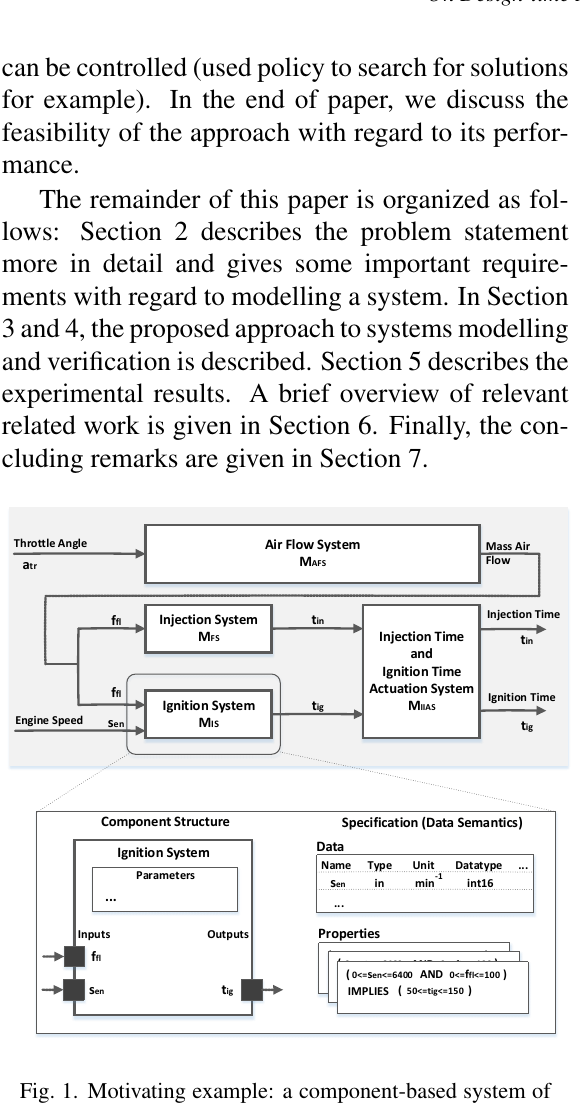
Fig. 1. Motivating example: a component-based system of automotive engine control function, adopted from ( 11 ) (top), and detailed view of the component Ignition System (struc- ture and specification,